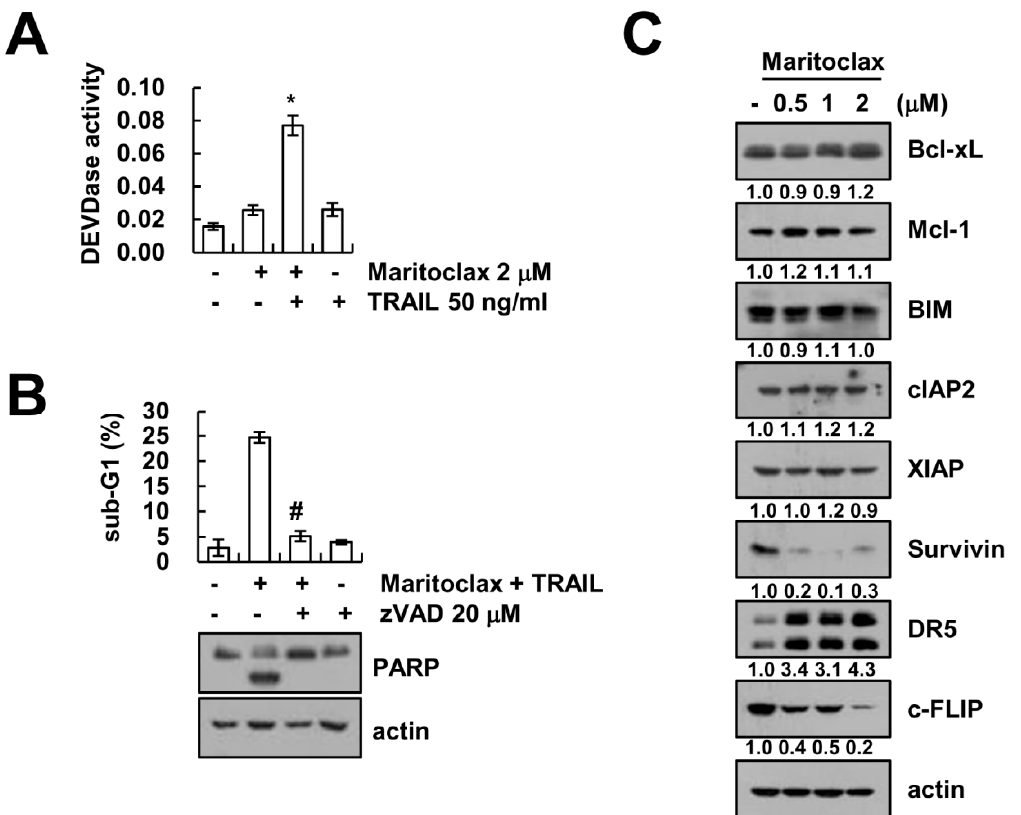
Figure 2. Combined maritoclax and TRAIL treatment induces caspase-dependent apoptosis. ( A ) Caki cells were treated with 50 ng/mL TRAIL in the presence or absence of 2 µ M maritoclax for 24 h. Caspase activities were determined using caspase-3 DEVDase assay kits. ( B ) Caki cells were treated with 2 µ M maritoclax plus 50 ng/mL TRAIL for 24 h in the presence or absence of 20 µ M z-VAD-fmk (zVAD). The sub-G1 fraction was measured by flow cytometry. The protein expression levels were determined by Western blotting. ( C ) Caki cells were treated with indicated concentrations of maritoclax for 24 h. The protein expression levels were determined by Western blotting. The band intensity of the proteins was measured using ImageJ (public domain JAVA image-processing program; http://rsb.info.nih.gov/ij). − , no treatment; +, treatment. The values in graph ( A , B ) represent the mean ± SD from three independent samples. * p < 0.01 compared to the control. # p < 0.01 compared to maritoclax plus TRAIL by ANOVA and Student-Newman-Keuls methods.